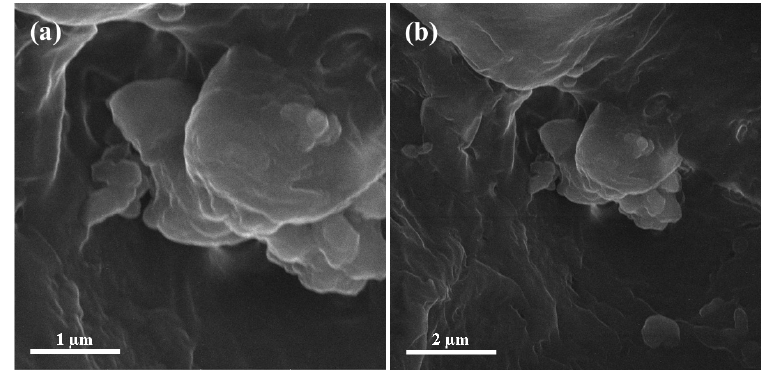
Figure 4. Scanning electron microscopy images of alumina urea-formaldehyde resin ( a ) 50,000× ( b ) 25,000×.